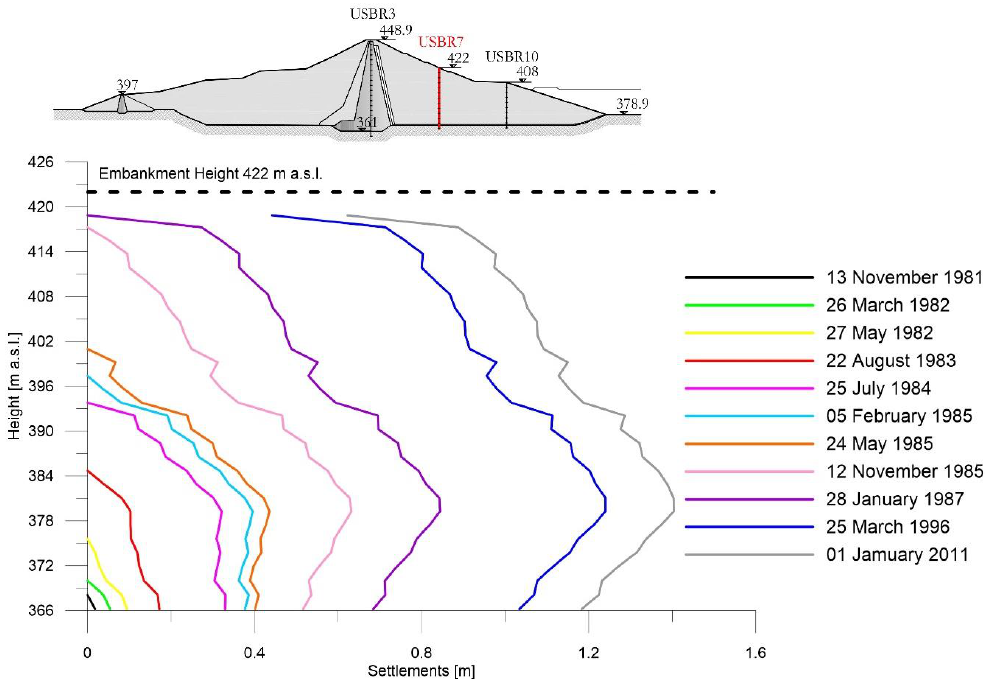
Figure 10. Extensometer USBR 7: settlement profiles observed during construction and working phases.